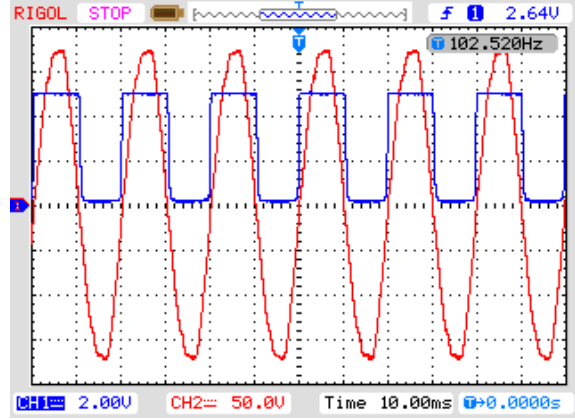
This is caused by some unwanted delays introduced by the voltage sensing circuit. How- Figure 16. Output of the input voltage senescing circuit. ever, these transients are not comparable with the value of output voltage. So, they have Figure 16. Output of the input voltage senescing circuit. no significant effect on the output.